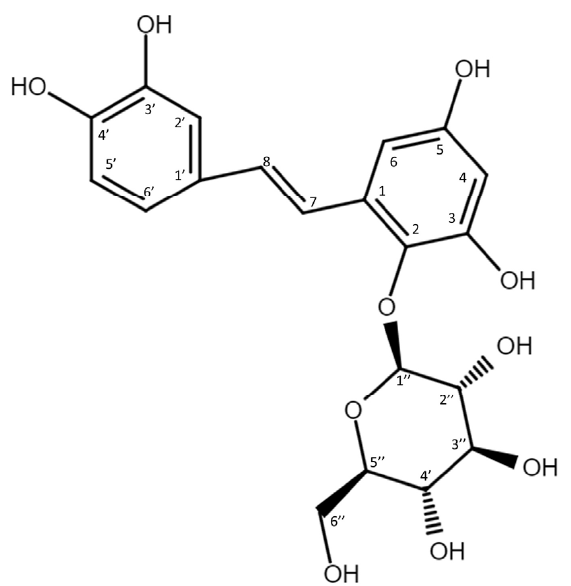
Figure 3. Chemical structure of the biotransformation product ( 1 ), 2,3,5,3 ′ ,4 ′ -pentahydroxystilbene-2- O - β -glucoside (PSG).